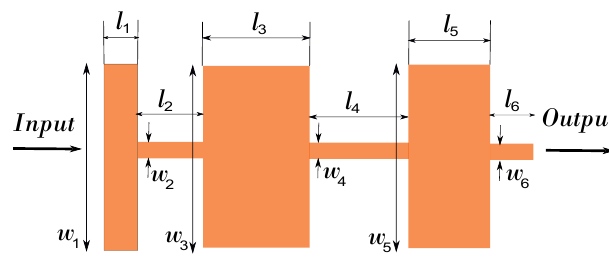
Figure 5. Top view of the layout of the lowpass filter under study.